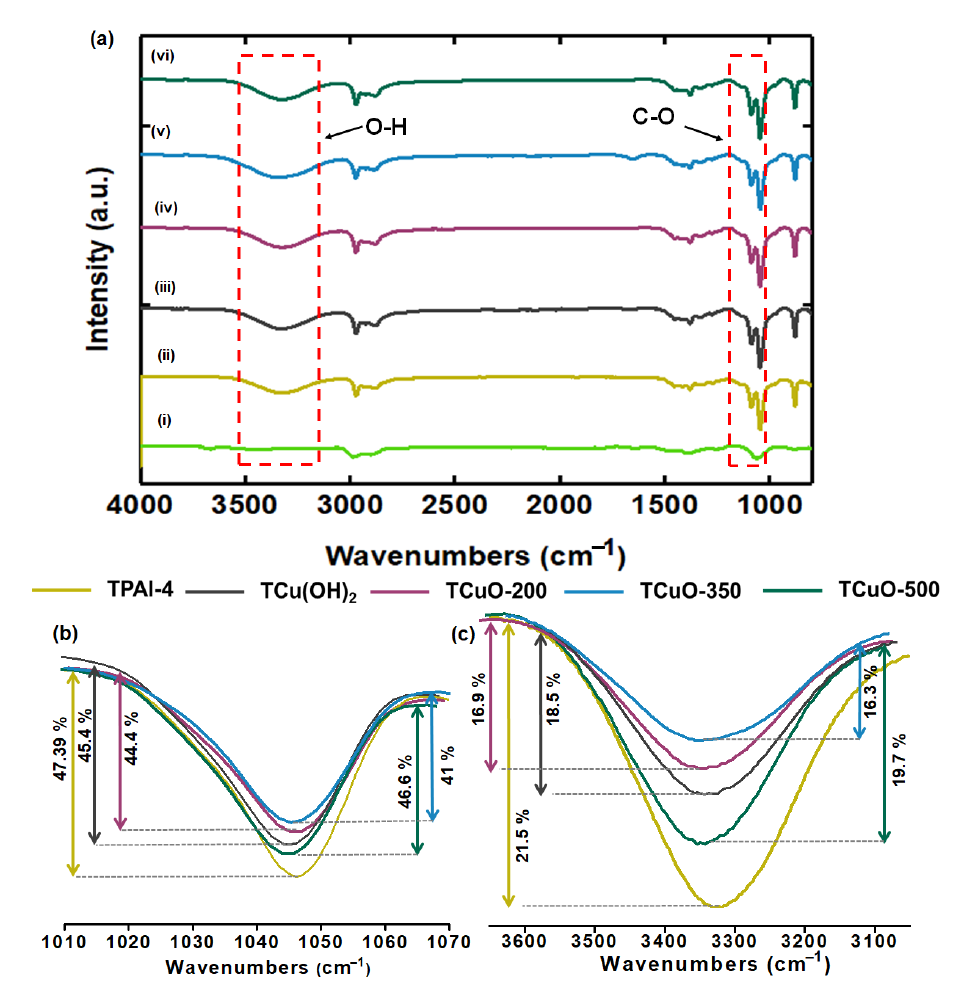
Figure 3. ( a ) FTIR spectra for (i) CuO-350 nanofiller, (ii) TPAI-4, (iii) TCu(OH) 2 , (iv) TCuO-200, (v) TCuO-350, and (vi) TCuO-500, the changes in intensity peak of ( b ) O-H stretching and ( c ) C-O stretching for TPAI-4, TCu(OH) 2 , TCuO-200, TCuO-350, and TCuO-500.